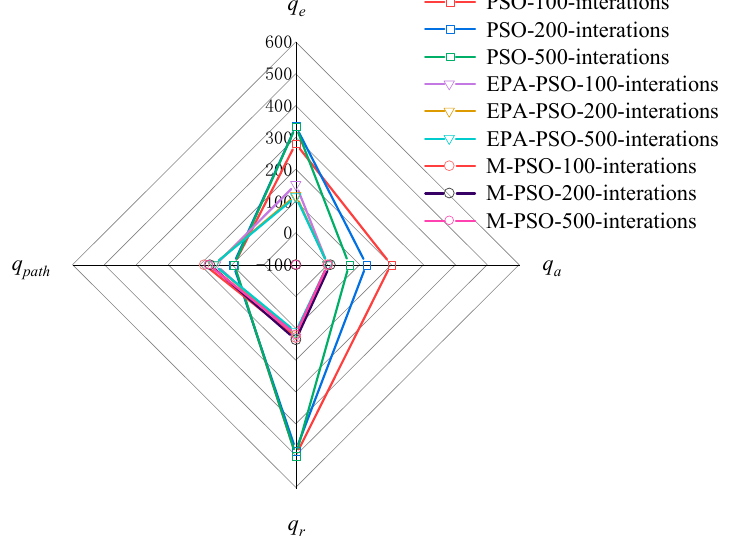
Figure 25. Radar chart of value of cost function. Table 4. The table of fitness correction.